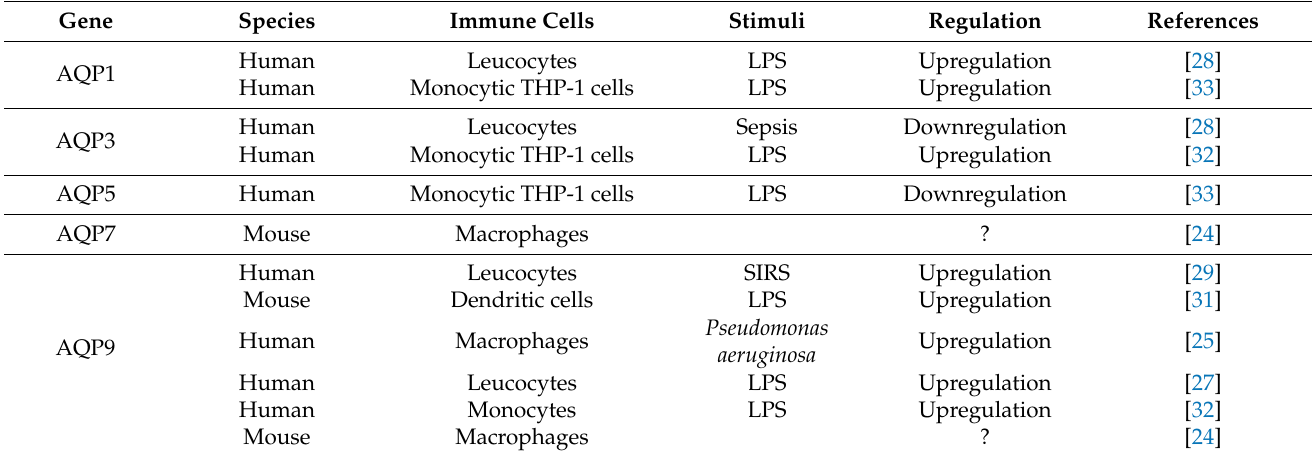
Figure 1. Aquaporins (AQPs) expression in immune cells involved in the inflammatory process. Illustration represents an injured tissue, adjacent blood vessel and immune cells involved in inflammation. The localization of each AQP isoform in the different immune cells is also represented. Table 1. Regulation of immune-related AQPs during